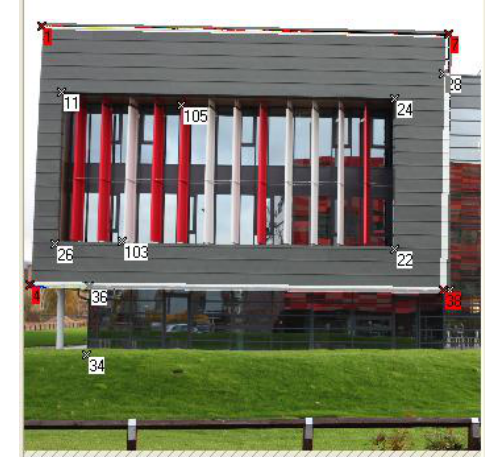
Figure 12. Creating 3D planes of the facades given the corner points